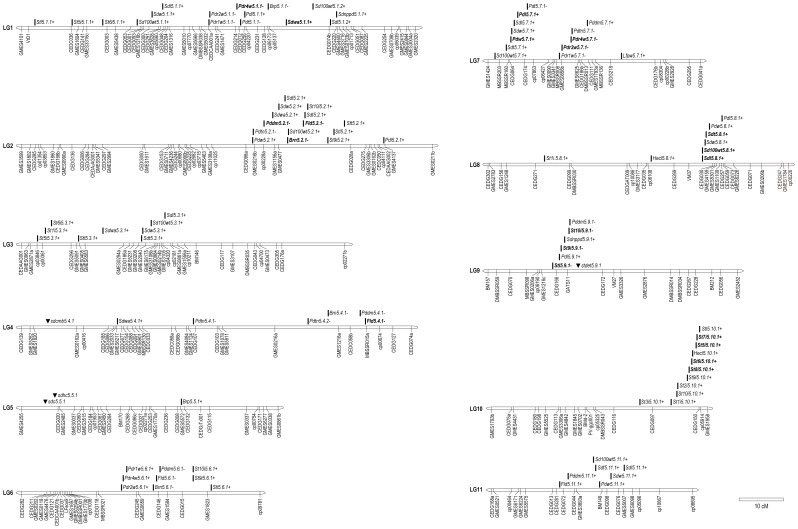
Distribution of the domestication-related QTLs and genes detected on each linkage group.The signs “▪”and “▾” indicate the position of detected QTLs and genes, respectively. The signs “+” and “-” after QTL and gene names indicate the direction of effect of alleles from cultivated mungbean. The QTLs in bold italic have the large effects (PVE ≥20%).